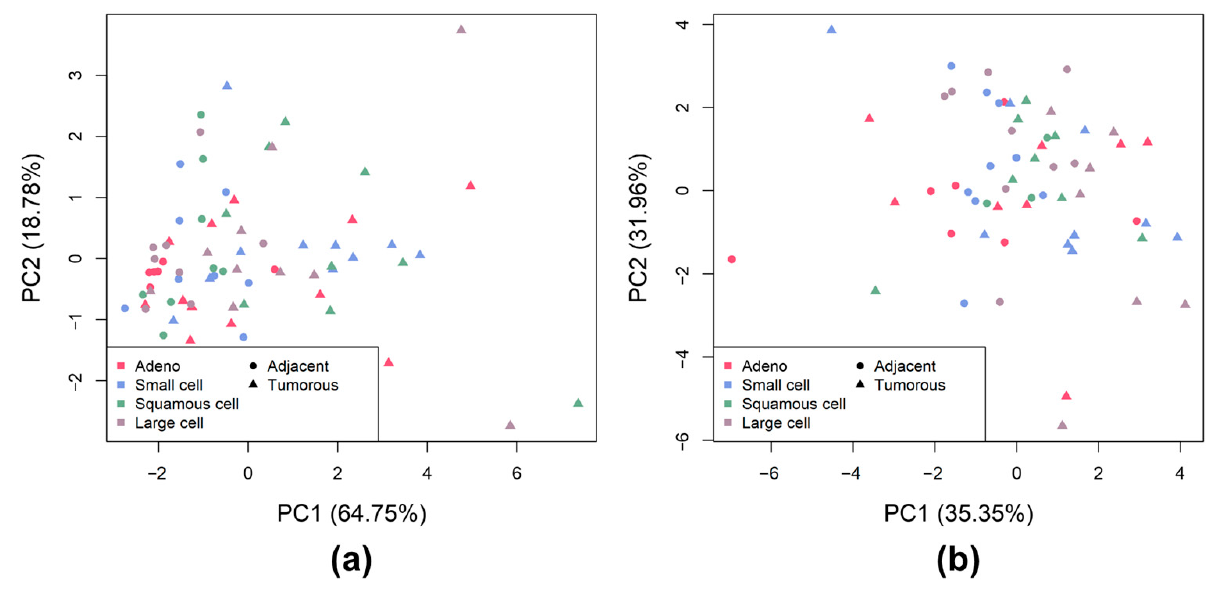
Figure 1. PCA of the analyzed samples ( a ): CS disaccharide abundances; ( b ): HS disaccharide abundances. Triangles and circles indicate tumor and tumor-adjacent samples, respectively. The different colors mark the different sample groups (pink for AC, blue for SCLC, green for SqCC, and grey for LCC).